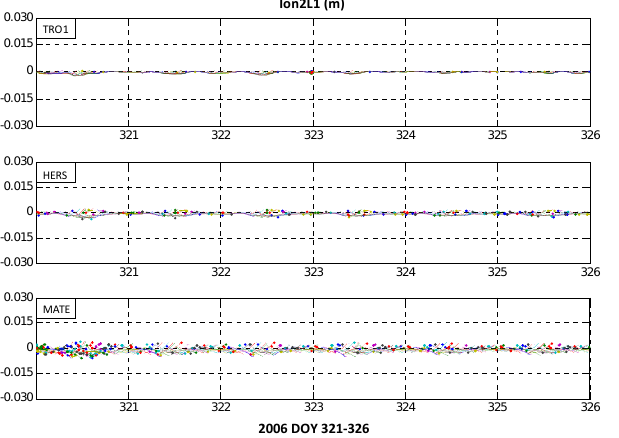
Fig. 11. STEC (TECU) for the three observation stations on 321‐326 in 2006.